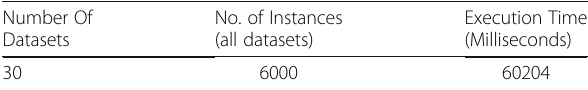
Table 3 Performance of LTAGD algorithm in terms of execution time